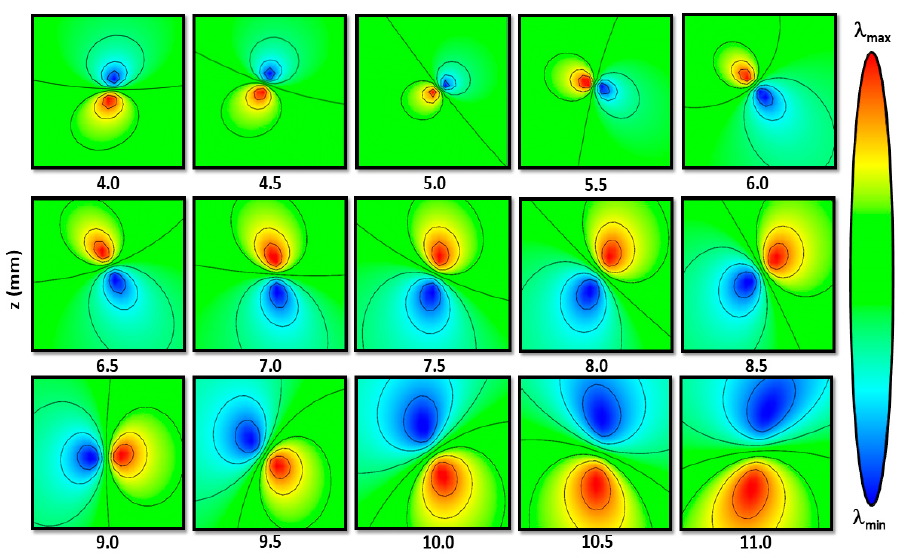
Figure 1. Numerical simulation of rotating anomalies in the spatio-spectral propagation of femtosecond vortex pulses in air (FOV = 12 × 12 µm 2 ). The centers of gravity (COG) of local spectral moments at distances z between 4 and 11 mm show the circulation of spectral eyes around the singularity during a full period of spectral Gouy rotation. To induce the orbital angular momentum, a binary spiral phase grating with a period of 8 µm and a phase stroke of 2 π at a central wavelength of 800 nm was illuminated by a Gaussian beam of a full-width-at-half-maximum (FWHM) spectral bandwidth of 12 nm with a waist radius of w 0 = 100 µm. The color code reaches from a lower limit (blue tail) of λ min = 793 nm to an upper limit (red tail) of λ max = 808 nm (±0.9 nm).